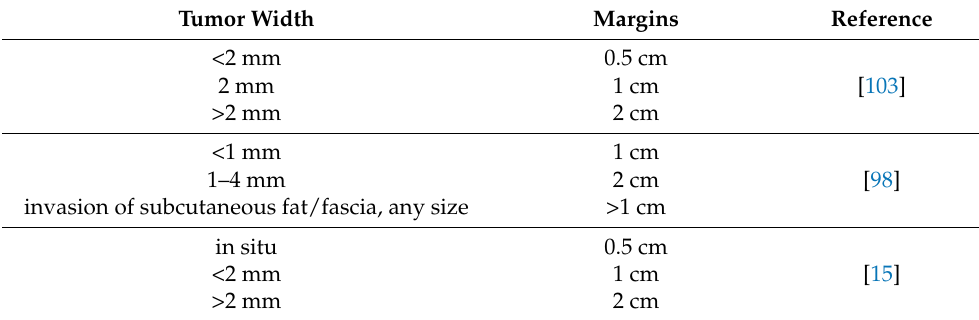
Table 5. Safety surgical margins in limited resection of vulvar and vaginal melanomas [15,103,107]. Tumor Width Margins Reference <2 mm 0.5 cm